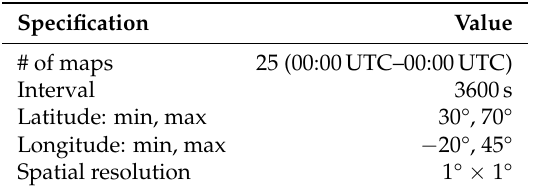
Table 1. Specifications of the TEC maps provided in the Regiomontan IONEX